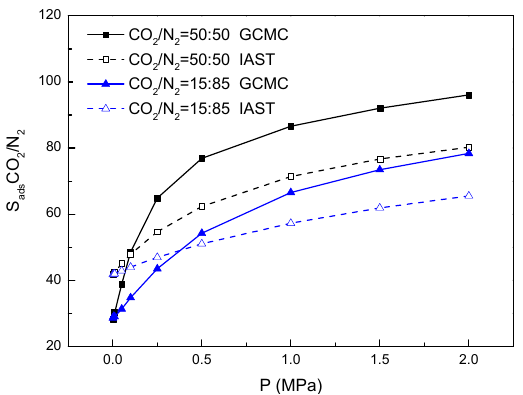
Figure 2. Adsorption selectivity of CO 2 /N 2 mixture (50:50 and 15:85) in bio-MOF-11 as a function of total pressure at 298 K. The filled symbols are from simulation and the open symbols are from IAST.